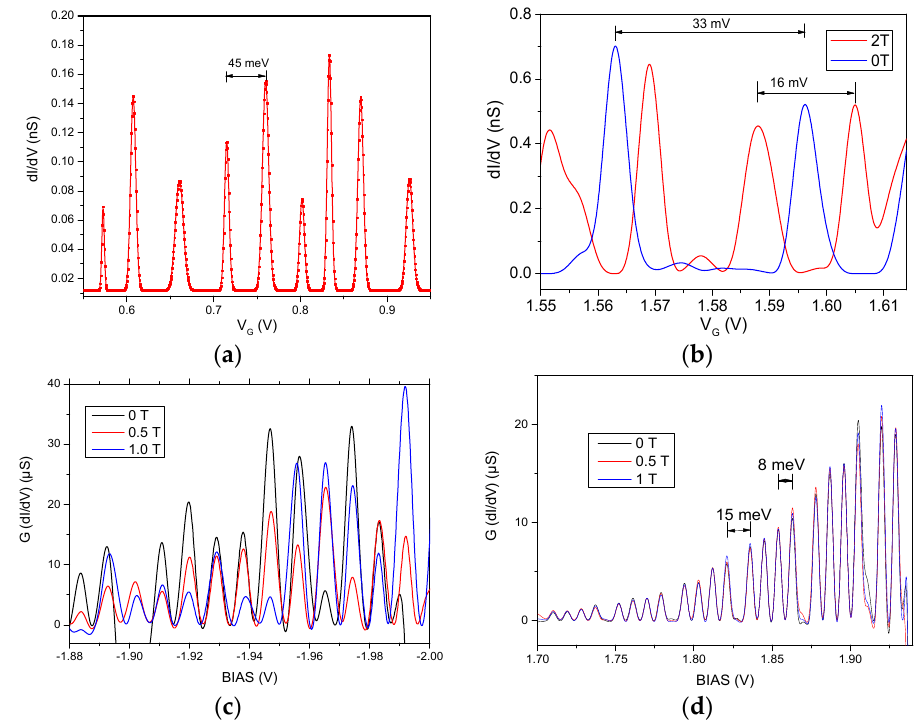
Figure 13. Coulomb blockade oscillations as a function of gate-source voltage (V G ) measured at V D = 400 mV ( a ). The spacing between individual blockades is 45 meV. Peak splitting in the presence of a magnetic field ( b ). The figure shows Coulomb blockades without a magnetic field (blue line) and in the presence of a magnetic field with B = 2T (red line). Note that the splitting is larger than the Zeeman splitting. Coulomb blockades observed on a dislocation network consisting of mixed dislocations ( c , d ). Blockades appear at negative ( c ) and positive bias ( d ), indicating single-electron and single-hole transitions on the same dislocations. All measurements at temperatures T = 380 mK.